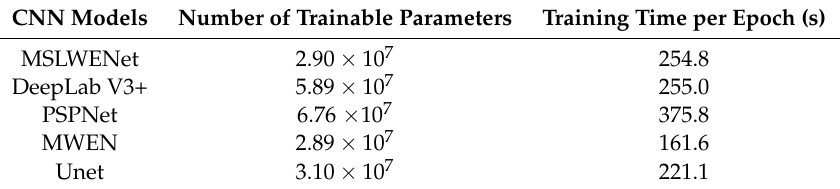
Table 2. Comparing CNN models in the number of parameters and training time.